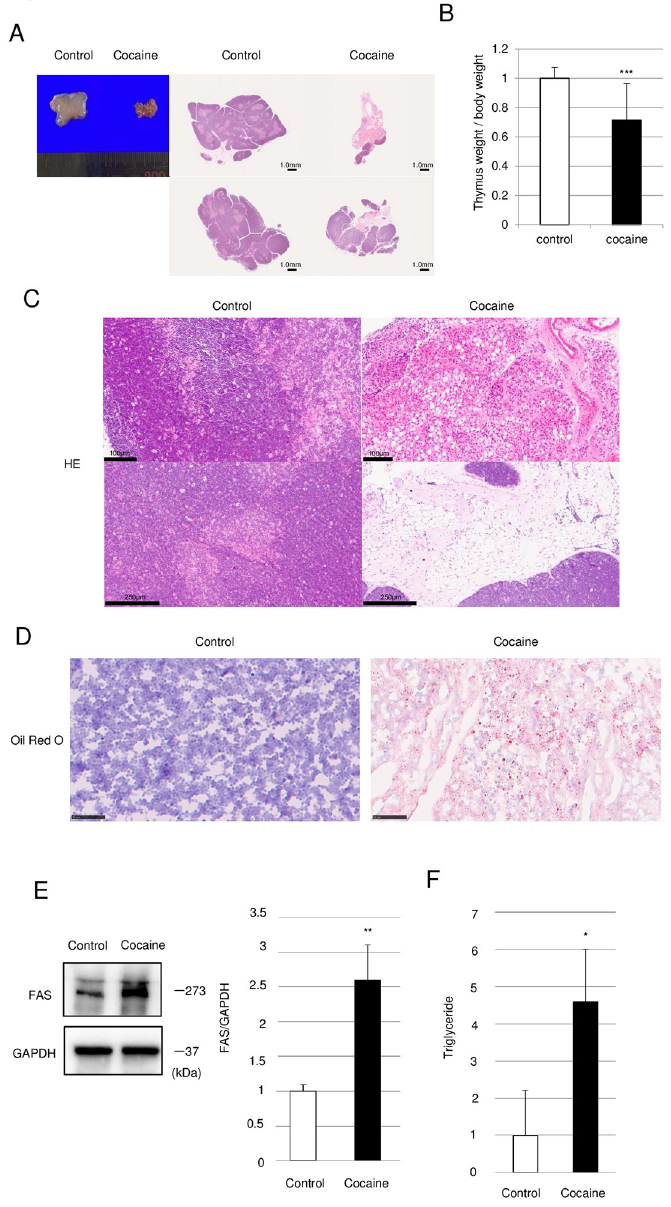
Fig 6. Reduction of thymic weight and size as well as ectopic development of adipocytes in thymus from rats administered cocaine for 14 days. Rats were treated with or without cocaine (20 mg/kg/day, 14 days). (A) Persistence of the reduction in thymic size in rats administered cocaine. Light microscopic and H&E staining images of thymus from rats administered cocaine for 14 days are shown. (B) Reduction in relative weight of thymus from rats administered cocaine for 14 days. (C) Ectopic development of adipocytes in thymus of rats administered cocaine for 14 days. Massive development of adipocytes was observed at the periphery of and within the cortex of the thymus. (D) Oil Red O staining images of thymus from rats administered cocaine for 14 day. (E) Immunoblot analysis of fatty acid synthase (FAS) in the thymus. GAPDH levels served as an internal control. (F) Relative levels of triglycerides in the thymus. Graph shows mean and S.E. � P < 0.05, �� P < 0.01, ��� P < 0.001 versus control.